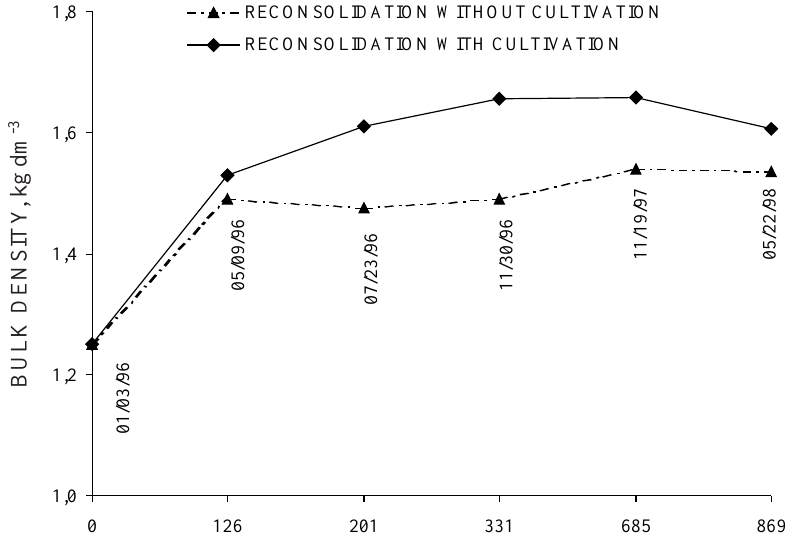
Figure 3. Bulk density at a soil depth of 0-0.075 m as a function of time in the reconsolidating soil treatments.